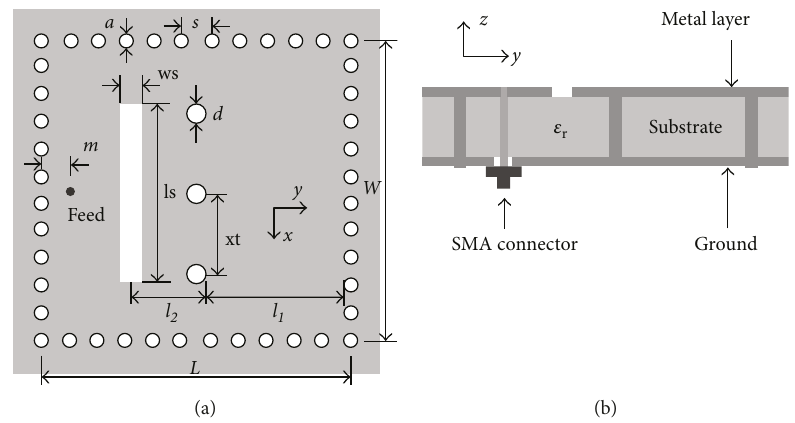
Figure 1: Con fi guration of the proposed fi ltering antenna. (a) Top view. (b) Side